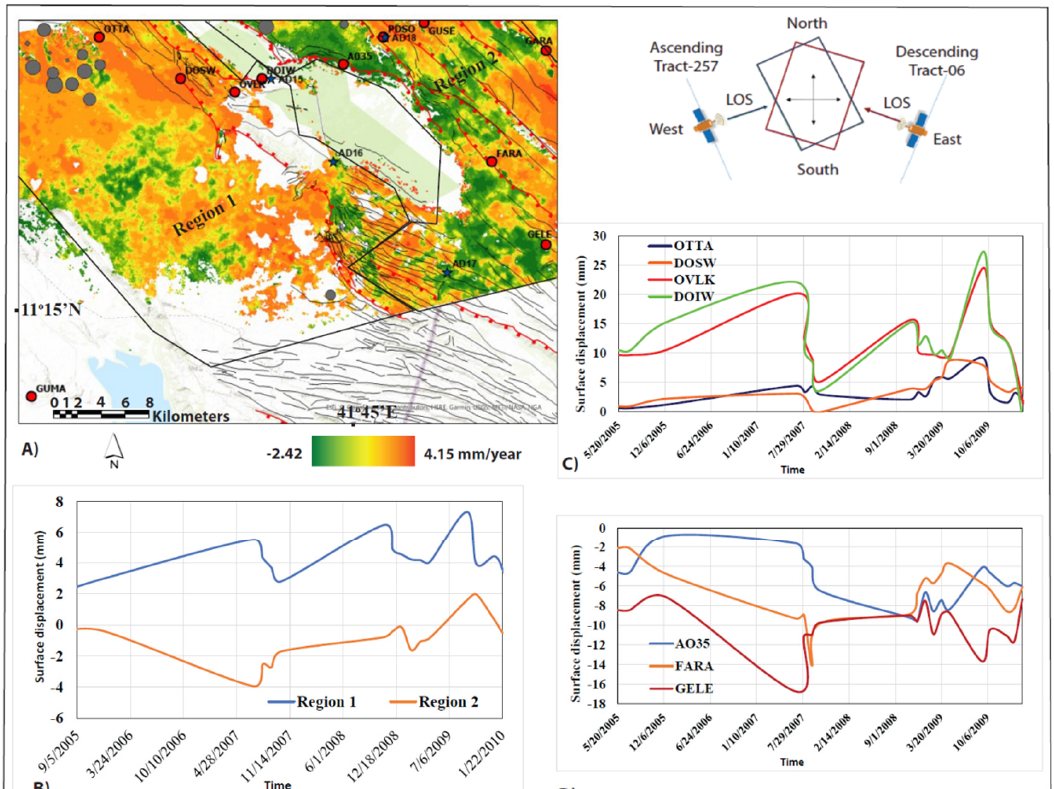
Figure 6. ( A ) The mean velocity at the LOS of the satellite for the ascending tract 257. It is referenced in the scale bar that ~0 mm/year surface deformation is a yellowish color, anything to the right is measured as a positive mean value and the negative mean value is to the left, spanning to a green color; ( B ) The multidimensional time profiling of the surface displacement velocity for the ascending tract 257 that is referenced temporally in the master scene (9 January 2007): the blue line represents the average of all the pixels confined in Region 1, and the orange line represents the mean LOS velocity derived from all the pixels found in Region 2; ( C ) The multidimensional time profiling of the surface displacement velocity for all the pixels that consist of the GPS sites in Region 1; ( D ) The multidimensional time profiling of the surface displacement velocity for all the pixels that consist of the GPS sites in Region 2.